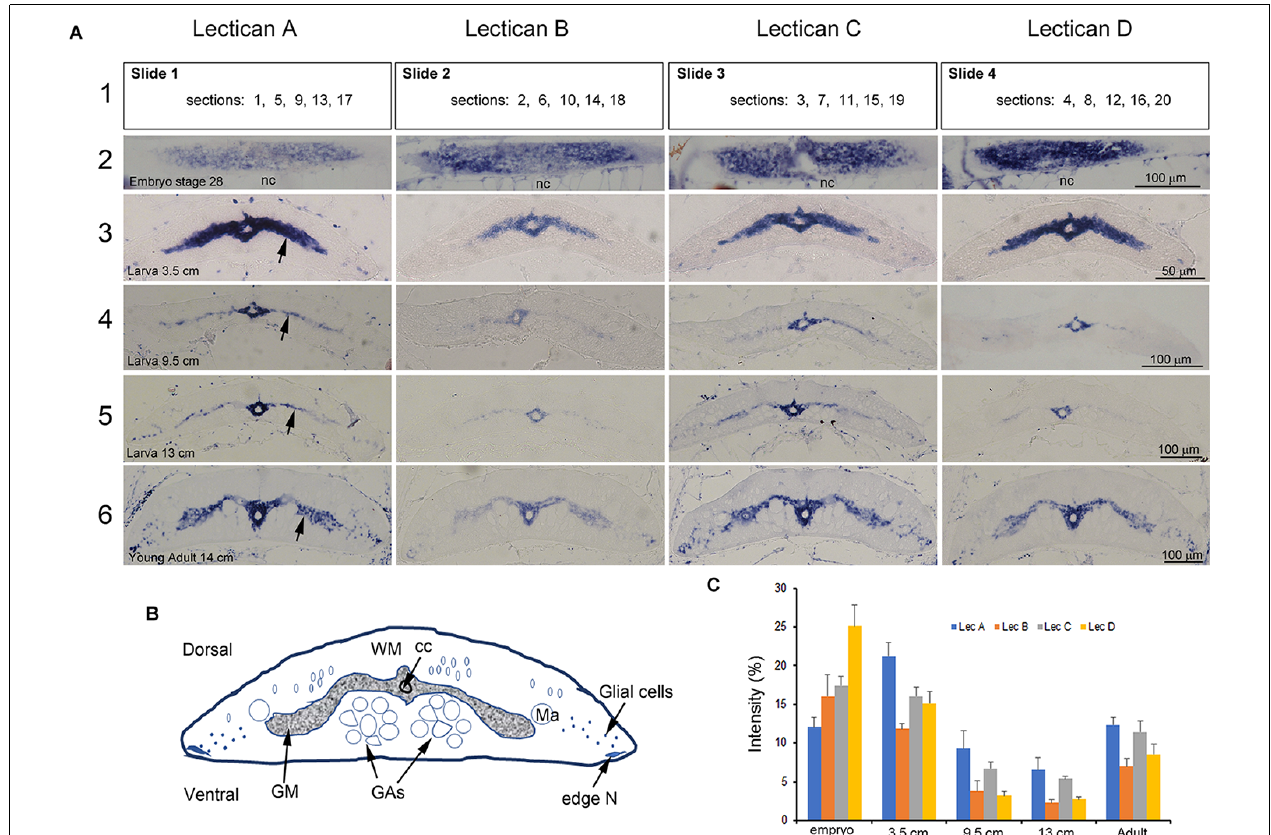
FIGURE 6 | Developmental expression of lamprey lecticans in the spinal cord. (A) ISH of lecticans in lamprey at different ages. Serial longitudinal (embryo only) or transverse sections from each animal’s SC at the level of the 5th gill were mounted alternately on four slides, as shown in the top row (row 1). Numbers in the rectangles present the order of the sections. ISH was performed on each of these slides using four different probes, LecA, LecB, LecC, and LecD, respectively. The developmental stage or size of the lamprey is indicated on the sections in column 1. The sections in each image are representative for that animal at that level, and thus are comparable between lecticans. Note that in the larva, lectican D predominated, whereas in the larval and adult stages, lecticans A and C predominated. The expression levels of all lecticans were relatively high at early larval stages, declined at later larval ages, and then increased again after metamorphosis to the adult stage. nc = notochord. ( B) A cartoon showing the structure of a transversely sectioned lamprey SC. Ma = Mauthner axon; GAs = Giant axons; WM = white matter; GM = gray matter; N = neuron; cc = central canal. (C) Semi-quantification of staining intensity shows the changes in the four lecticans during development. “Intensity (%)” = 100 × the ratio between the number of pixels that are labeled by ISH, and the total number of pixels encompassed within the SC perimeter (see “Methods”